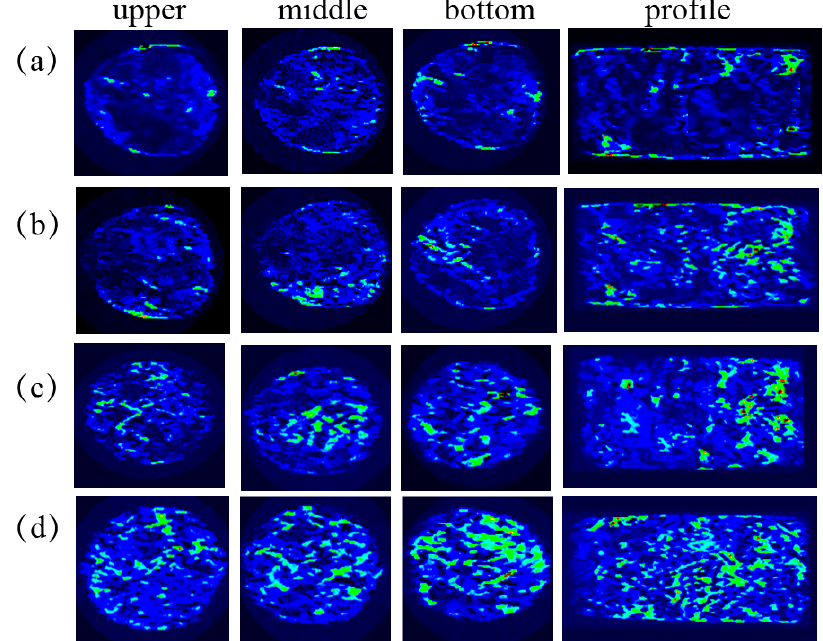
Figure 8. The T 2 —weighted images of the thawed soils under different freezing temperatures: ( a ) − 5 ° C ; ( b ) − 10 ° C ; ( c ) − 20 ° C and ( d ) − 30 ° C .